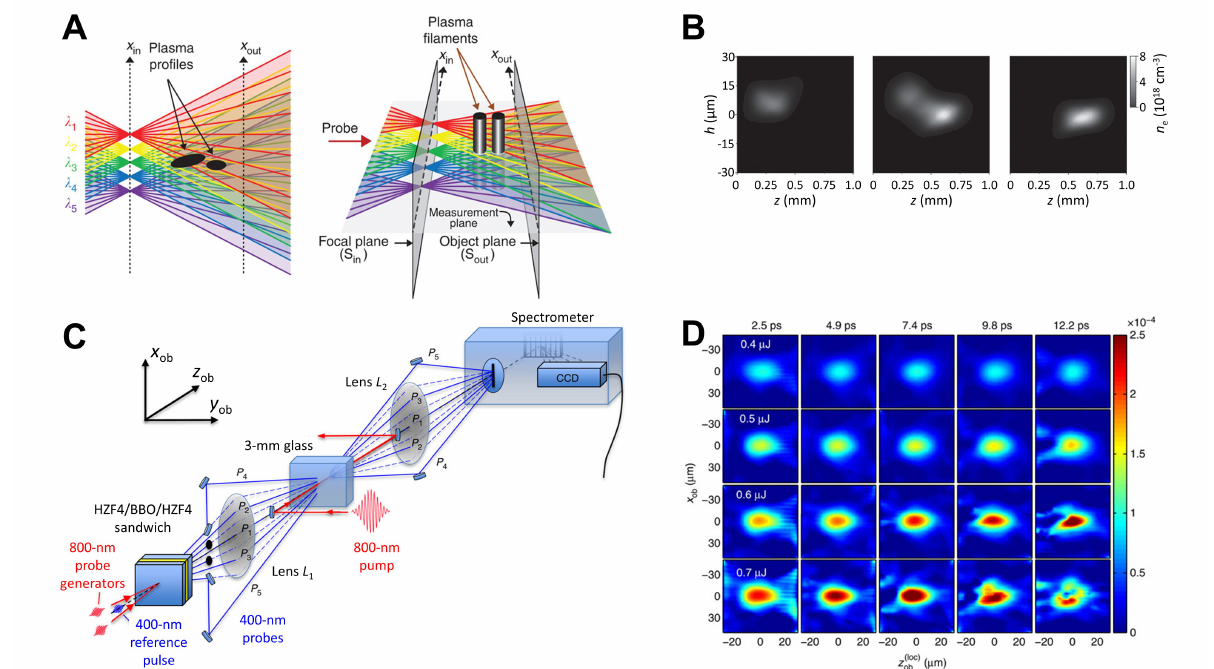
Fig. 6. Ultrafast tomographic imaging. (A) Schematic of SMT. (B) Imaging of plasma dynamics with SMT. (C) Schematic of tomographic imag- ing with the FDT. (D) Imaging of light pulse propagation with the FDT. ©Figure courtesy of Ref. [7] and